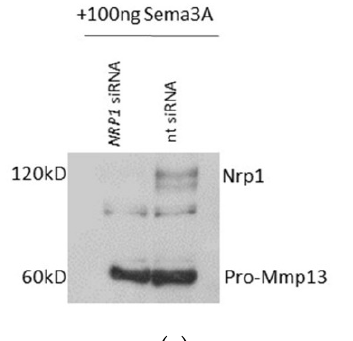
Figure 5. Sema3A stimulation of NRP1 knockdown cells and control OA chondrocytes. ( a ) Relative gene expression of MMP13 was determined in NRP1 knockdown cells after stimulation with 1, 10 and 100ng recombinant Sema3A. Unstimulated NRP1 knockdown cells served as control. One sample t -test, n = 3–4, * p ≤ 0.05; ( b ) Relative gene expression of MMP13 was determined in control (nt) cells after stimulation with 1, 10 and 100 ng Sema3A. Unstimulated control (nt) cells served as control. One sample t -test, n = 3–4, * p ≤ 0.05; ( c ) Protein expression of Mmp13 was determined in NRP1 knockdown and control cells after stimulation with 100 ng Sema3A. Representative Western blot is shown. (BioRender was used to create Figure 5A,B).